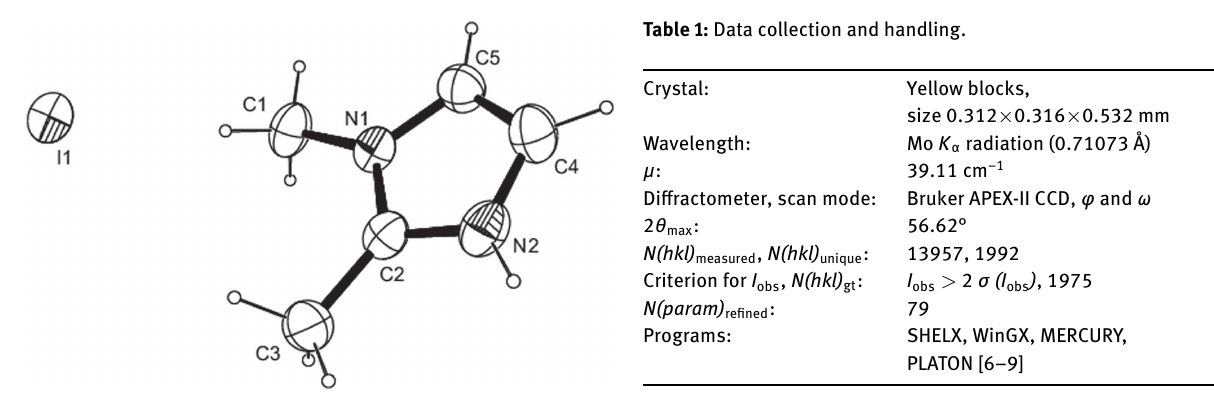
Table 2: Atomic coordinates and displacement parameters (in Å 2